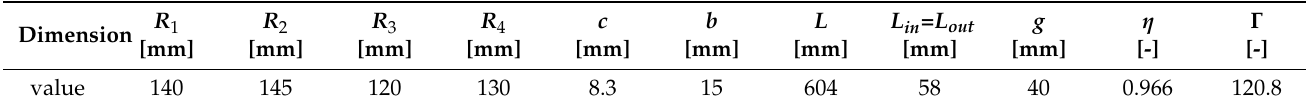
Figure 17. Air gap and outside volume geometry as used in the initial numerical model of the grooved air gap from Bouafia [7]. The applied boundary conditions are also depicted. Table 8. Dimensions and geometrical parameters of the considered grooved air gap from Bouafia